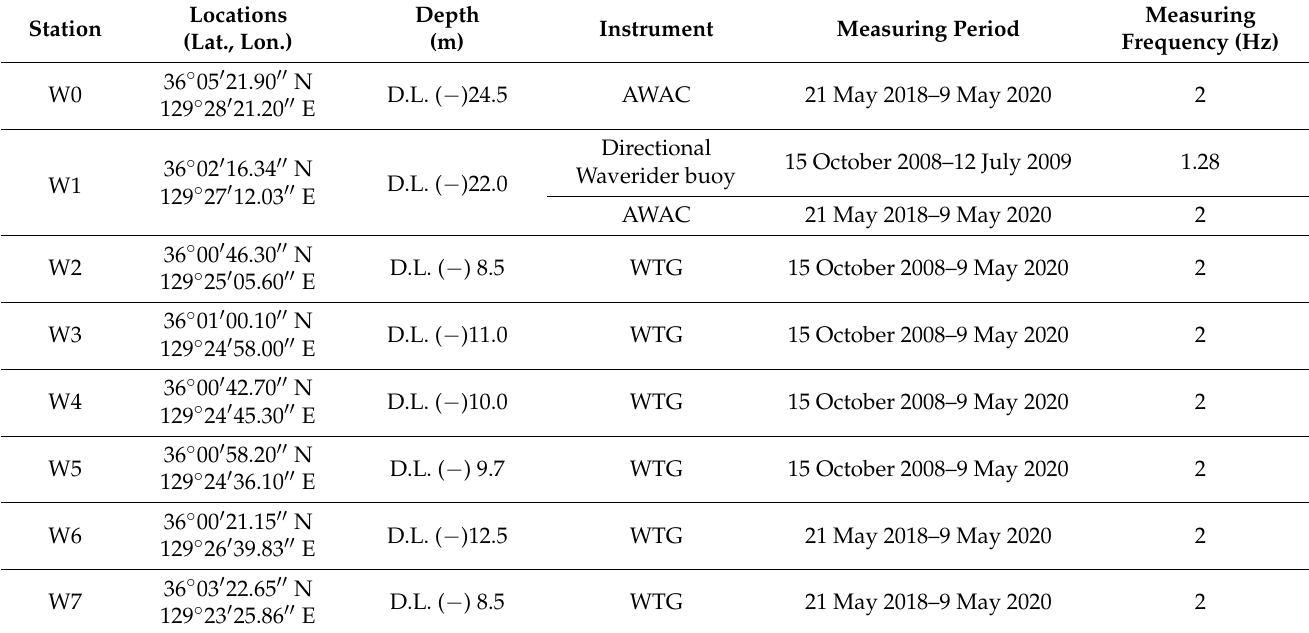
Table 1. List of observational instruments, locations, installation depths, and measuring